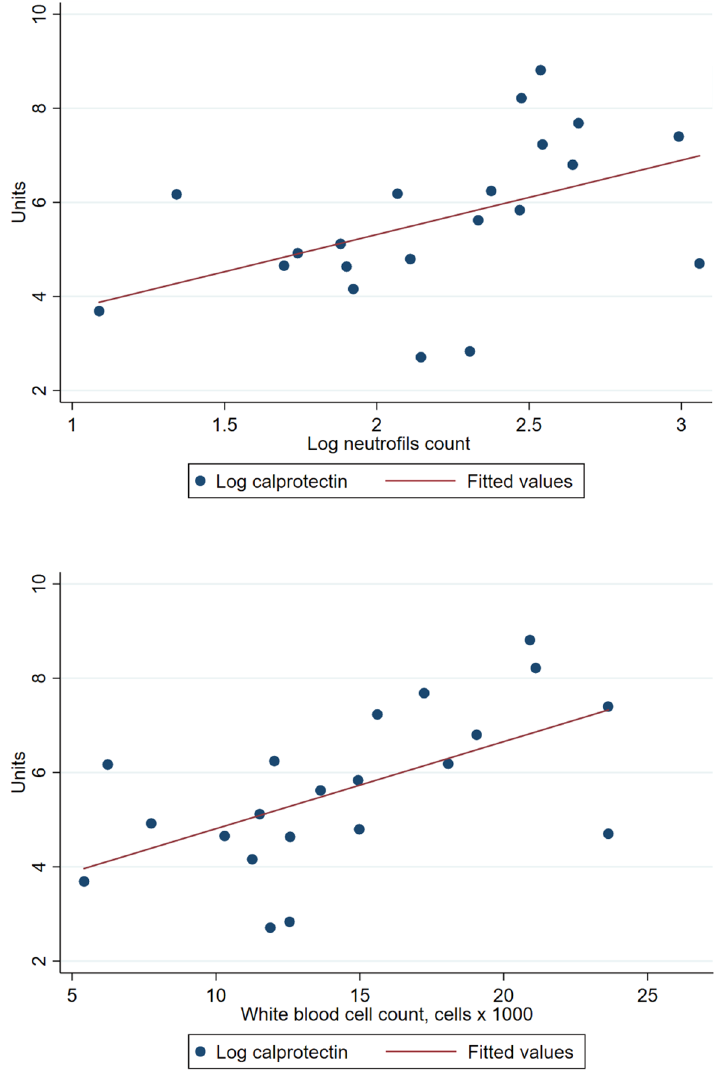
Figure 2. Correlation between fecal calprotectin concentrations and neutrophils count (slope = 1.57; intercept = 2.15) (above) and white blood cell count (slope = 0.18; intercept = 2.96) (below). A significant positive correlation was observed, respectively p = 0.03and p = 0.006. Software: STATA 15